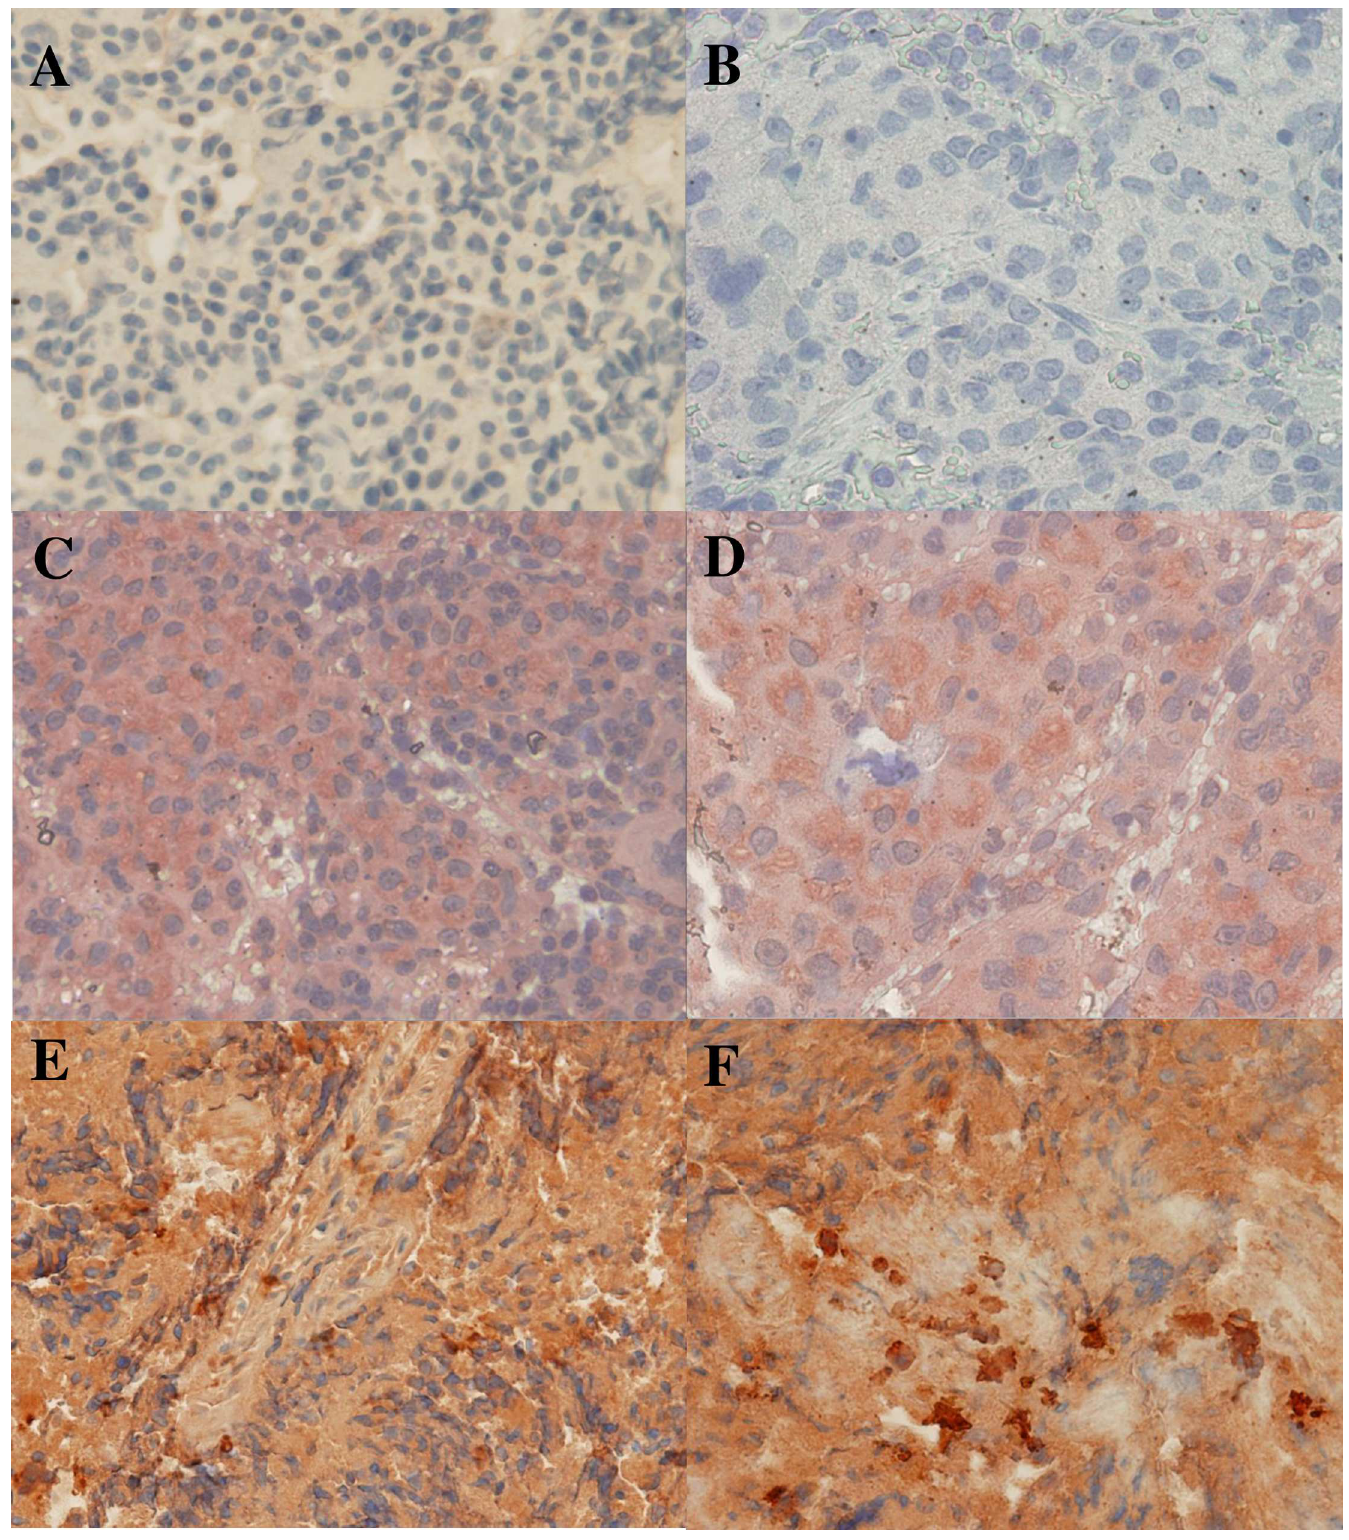
Fig 3. Immunohistochemical staining of armadillo spleen sections for the M . leprae -specific antigen, PGL-I, with a rabbit polyclonal antibody raised against this antigen. A) Wild infected armadillo B7 section stained with pre-immune rabbit serum, negative control; B) NHDP uninfected armadillo 13–02 stained with rabbit